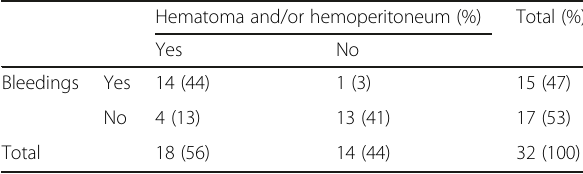
Table 4 Distribution of patients showing internal